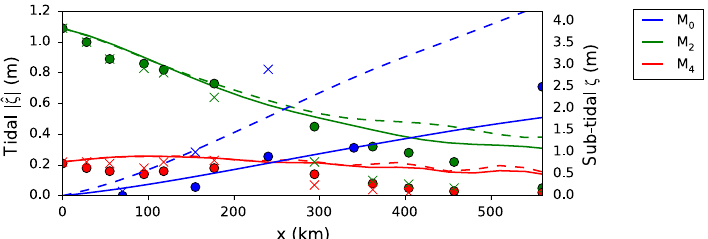
Figure 9. Water level amplitude for the Yangtze case when the effect of the river discharge on the eddy viscosity and partial slip parameter is omitted. The figure shows results for a dry season situation (solid line and dots) and a wet season situation (dashed line and crosses); see Fig. 7 for more explanation. The M 2 tide is damped less and there is a smaller difference between the M 2 tidal amplitude in the wet and dry seasons.